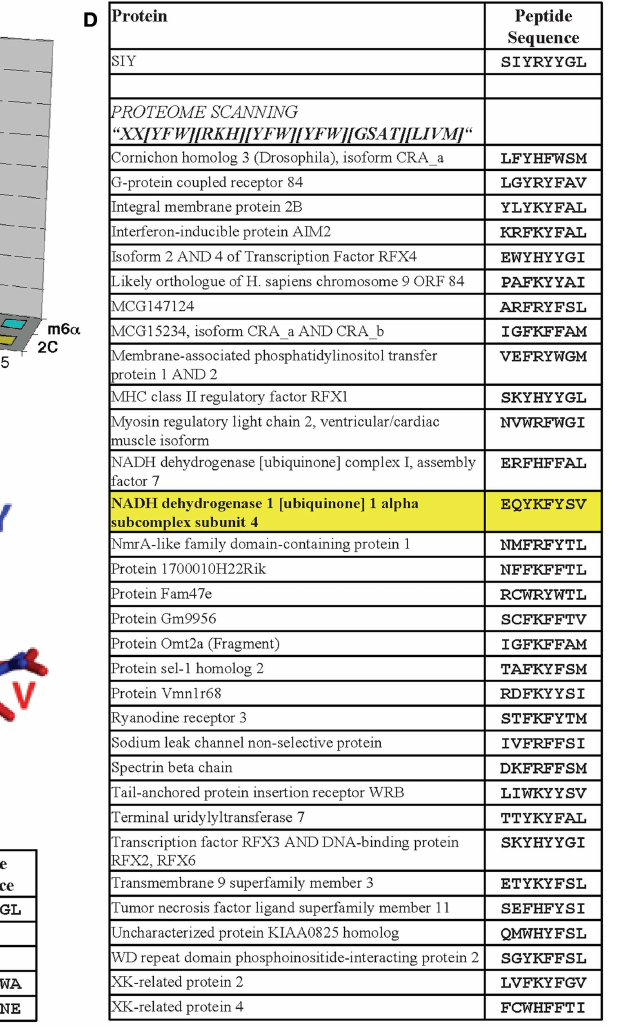
FIGURE 2 |T cell receptor affinity, specificity, and cross-reactivity in the 2CTCR system . (A) The m6 α TCR engineered from the 2CTCR for increased affinity for QL9/L d exhibited more sensitive reactivity with structurally related peptides with single-amino acid substitutions. Sensitization doses of various QL9 position 5 variant peptides for IL-2 production by CD8-negativeTCR transfectants are shown.The log of the SD 50 value was plotted for each of the peptides used to stimulate 2CTCR (yellow bars) and m6 α TCR (blue bars) transfectants [*Reproduced with permission from Ref. (56)]. (B) The 2CTCR reacts with the agonist SIY peptide/K b complex and the putative positive-selecting peptide dEV8/K b complex with K d values of 30 and 80 µ M, respectively.While the sequences share only two amino acids in common,